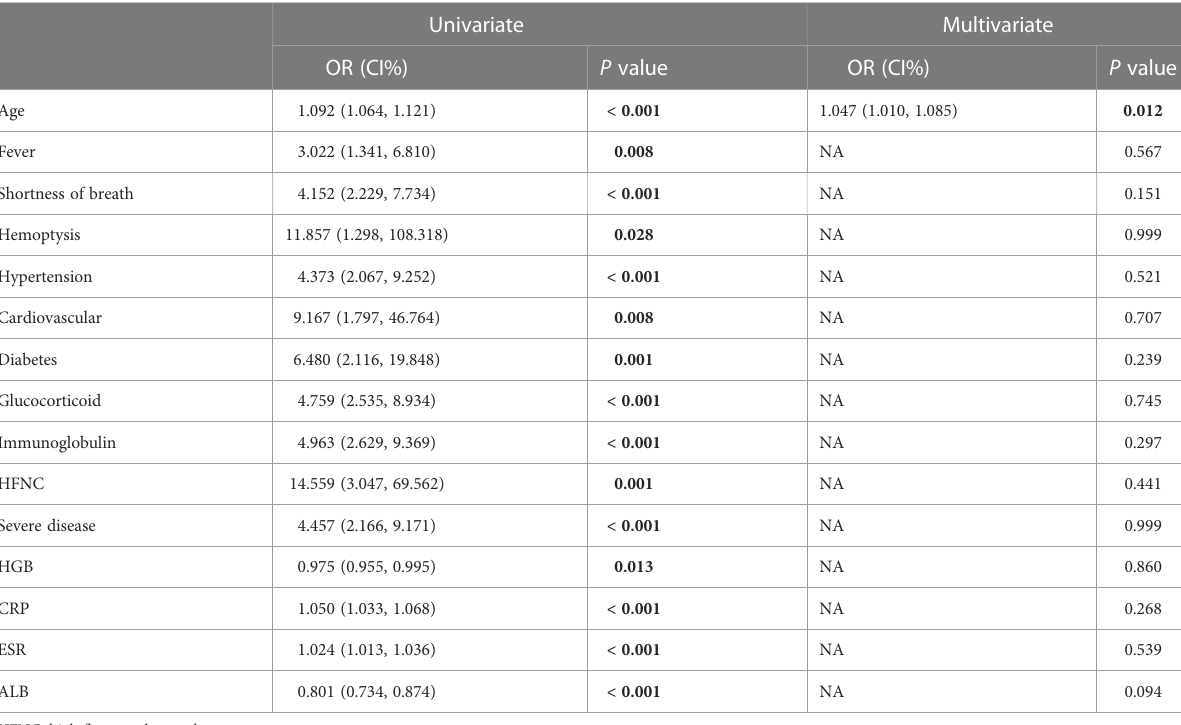
TABLE 3 Univariate and multivariate logistic regression analyses for risk factors at baseline of COVID-19 patients with pulmonary fi